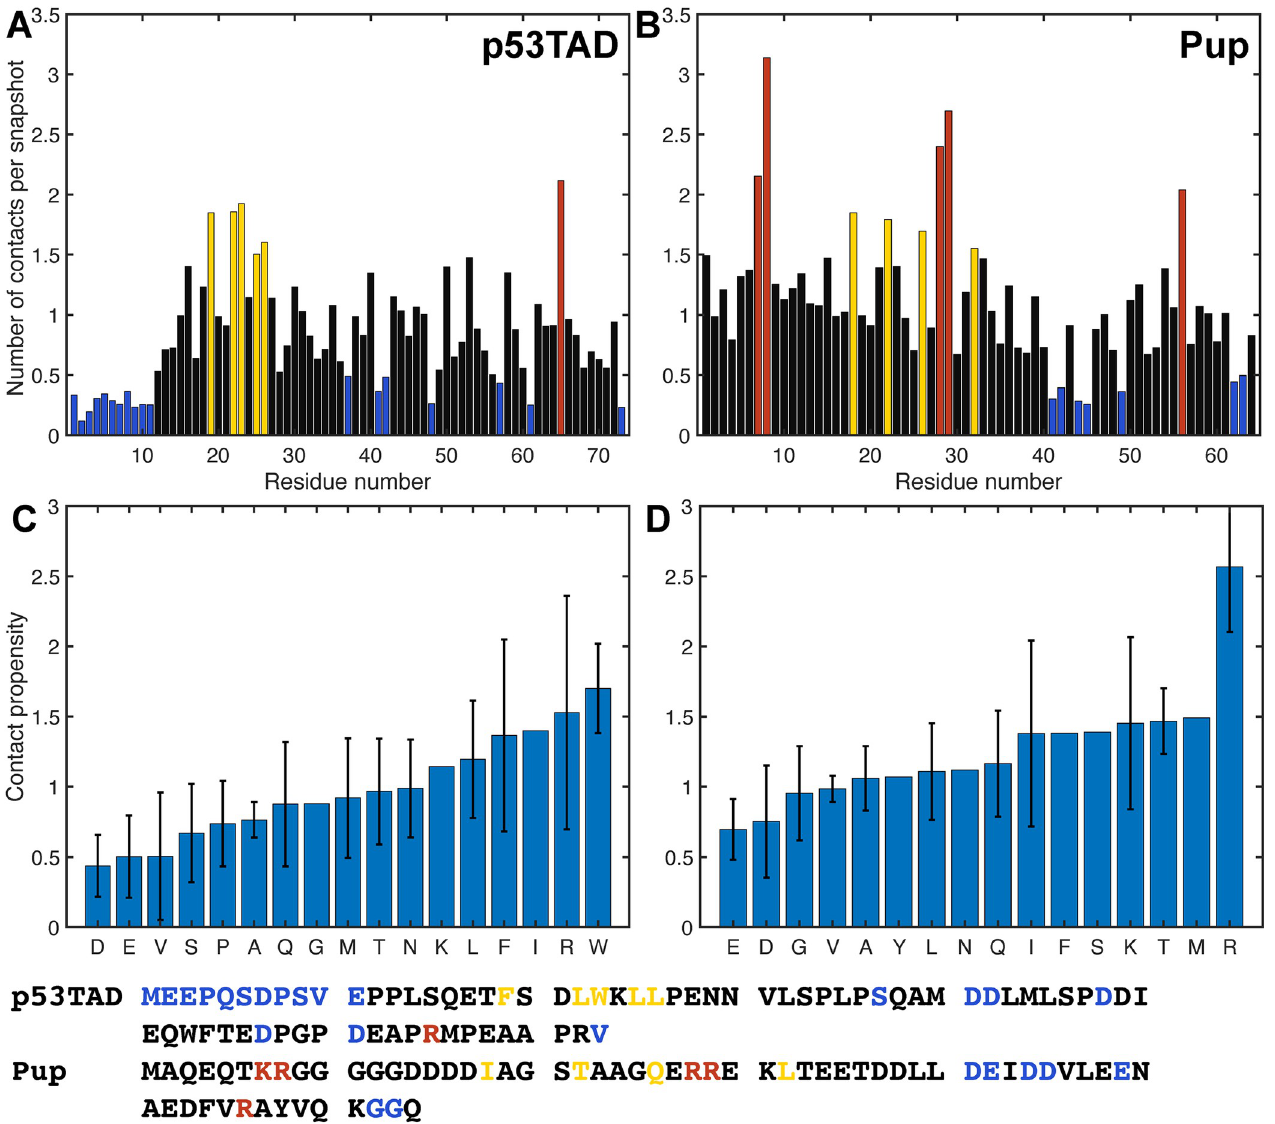
Fig 5. Number of close contacts formed by each residue during MD simulations of p53TAD and Pup (without outliers) along with average residue-type specific contact propensities. For each residue, the number of contacts was normalized by the number of snapshots for (A) p53TAD and (B) Pup. Residues with their number of contacts per snapshot below 0.5 are depicted in blue, 0.5–1.5 in black, 1.5–2 in yellow, and above 2 in red. Primary sequences of p53TAD and Pup are given at the bottom and colored as in Panels A, B. Average contact propensities according to amino-acid residue type, which is the number of contacts per snapshot averaged over all residues of the same type, are shown for (C) p53TAD and (D) Pup. Error bars correspond to the standard deviations among different residues of the same